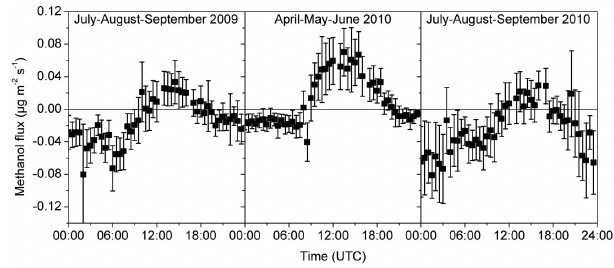
Fig. 4. Mean diurnal evolutions of methanol flux (error bars are 95% confidence intervals).